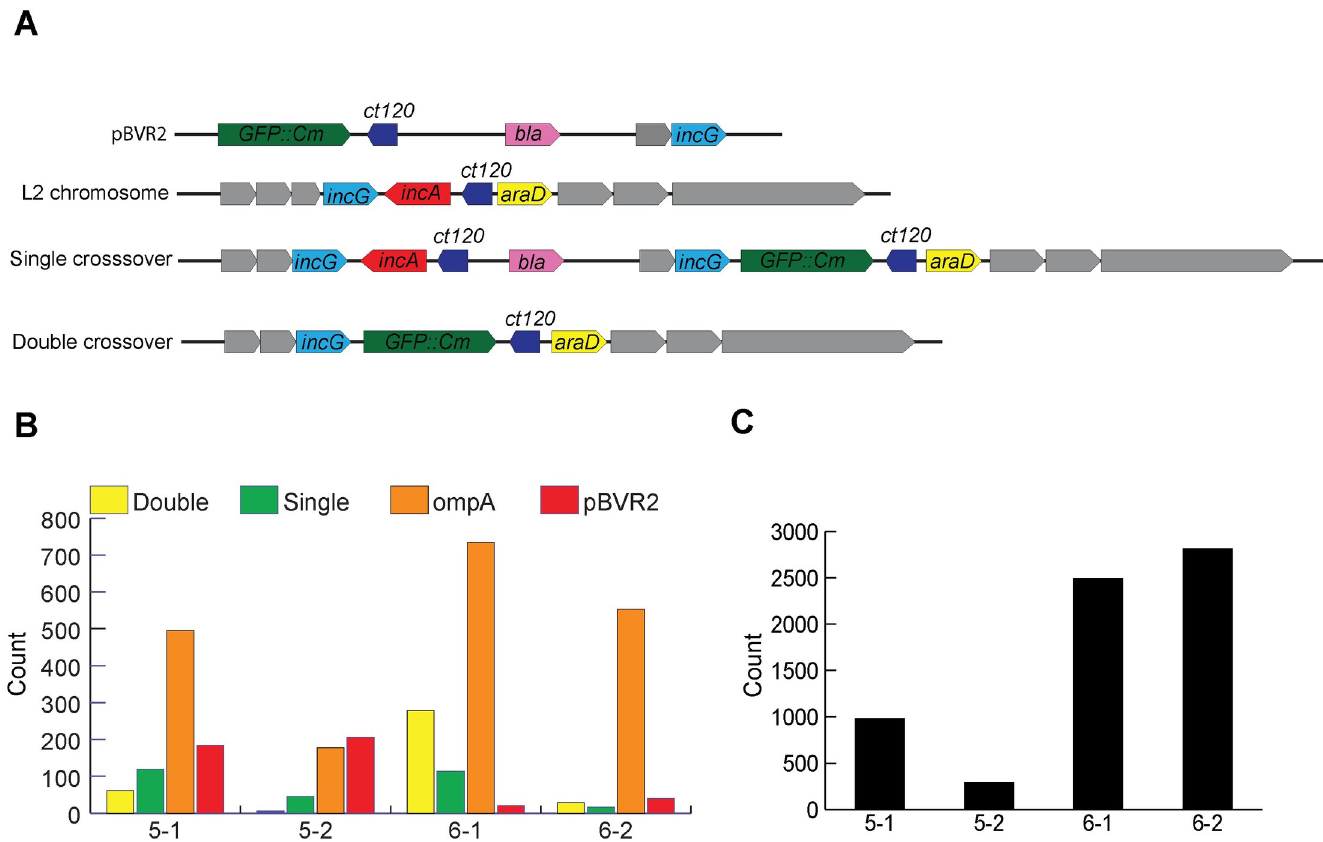
Fig 5. Plasmid pBVR2 exists as both an integration into the C . trachomatis chromosome and an episomal unit. C . trachomatis genomic DNA was sequenced via PACBIO whole genome sequencing, and the reads were assembled and parsed for the presence of genes indicating the integration of pBVR2 plasmid in the chromosome. ( A ) Gene map of pBVR plasmid and possible chromosome integration scenarios. ( B ) Counts of assembled whole genome read data parsed to determine existence of different integration sequences. The labels 5–1 and 5–2 denote the C . trachomatis clones derived from isolate 5B while 6–1 and 6–2 denote clones derived from isolate 6F.( C ) Counts of assembled read data denoting presence of pL2 native plasmid. Note: pBVR2 plasmid can integrate into chromosome from either the incG or the ct_120 regions of homology, though only one representative single crossover is shown in the gene map.